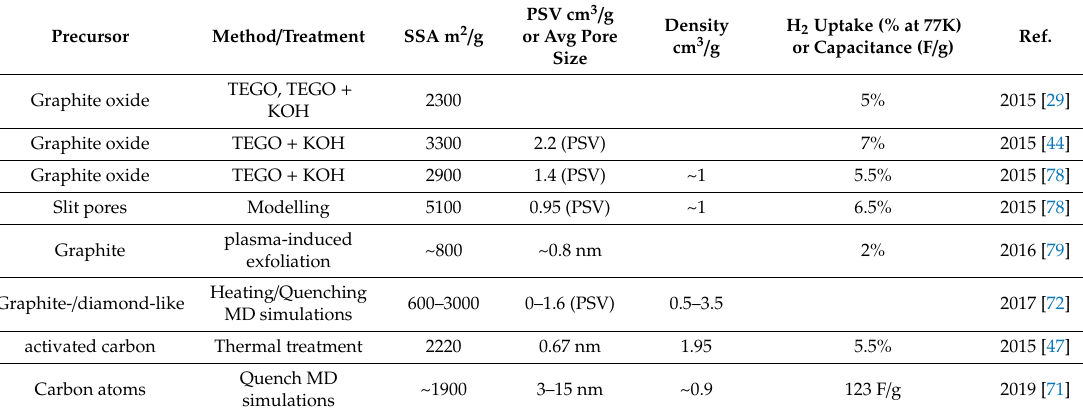
Table 1. Disordered GNM and their structural